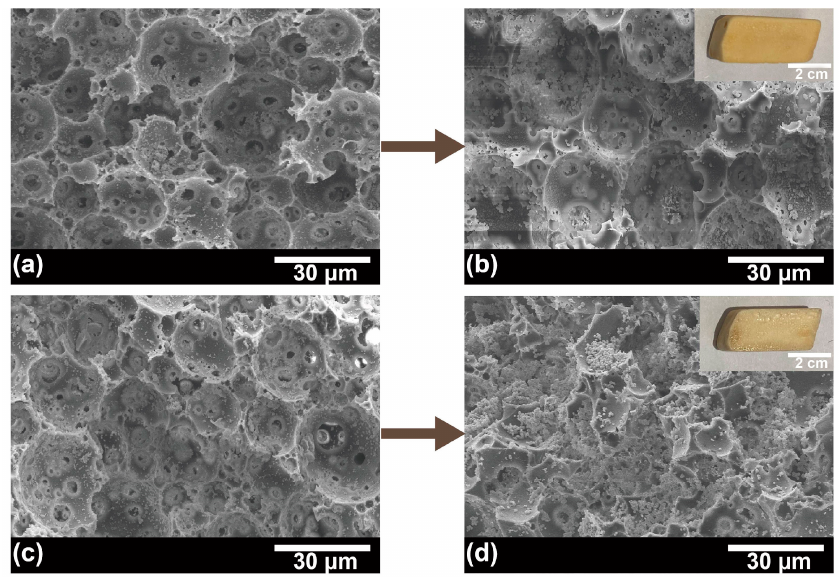
Figure 6. The L -lactic acid concentration for suspended and immobilized P. acidilactici on different PolyHIPE scaffolds at 42 °C.